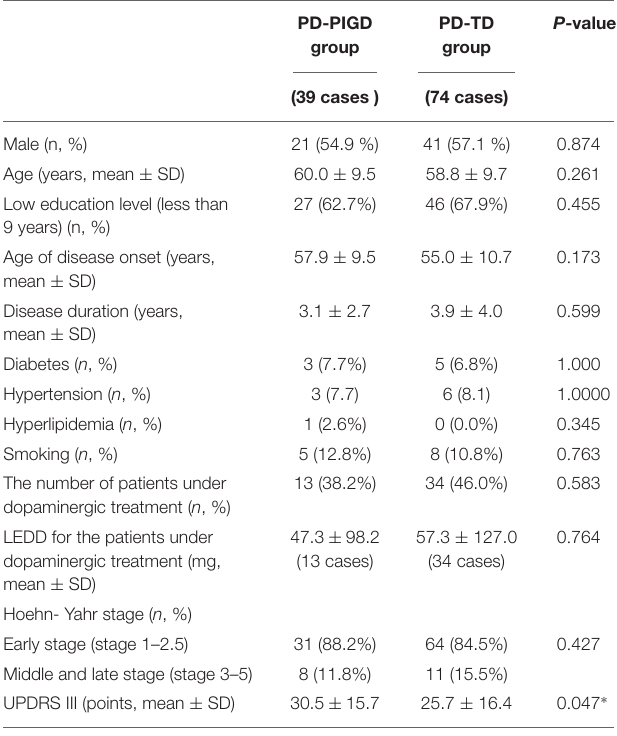
TABLE 1 | Clinical variables of PD-PIGD and PD-TD groups.